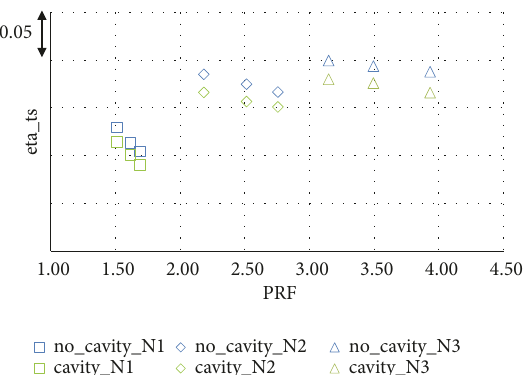
Figure 21: Total-to-static efficiency vs PRF comparison, partial hub admission.